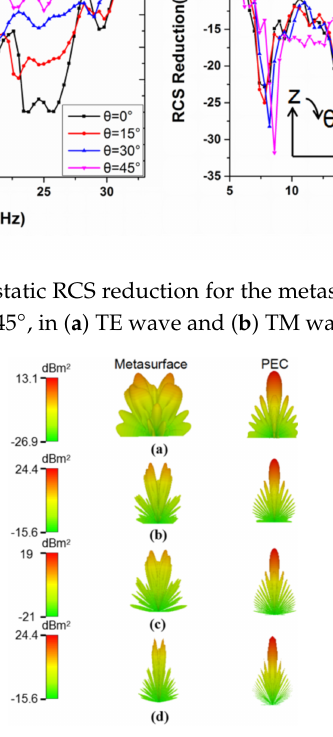
Figure 8. Three-dimensional scattering patterns of metasurface and PEC at di ff erent frequencies: ( a ) 7.2 GHz, ( b ) 14.6 GHz, ( c ) 17.2 GHz, and ( d ) 27.6